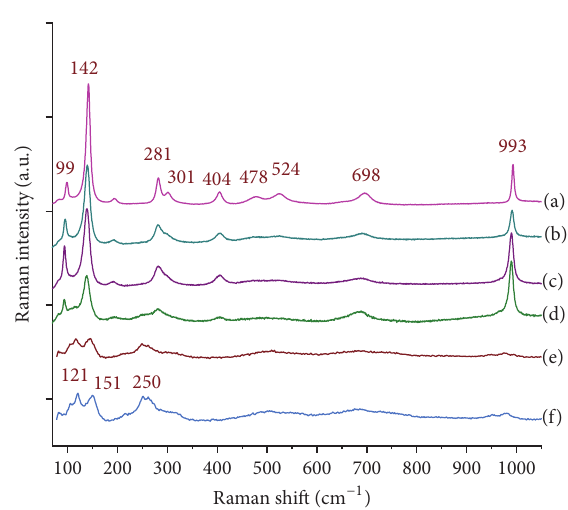
Figure 5: Raman spectra of samples (a) V 2 O 5 , (b) V 2 O 5 -1Ag, (c) V 2 O 5 -5Ag, (d) V 2 O 5 -10Ag, (e) V 2 O 5 -15Ag, and (f) V 2 O 5